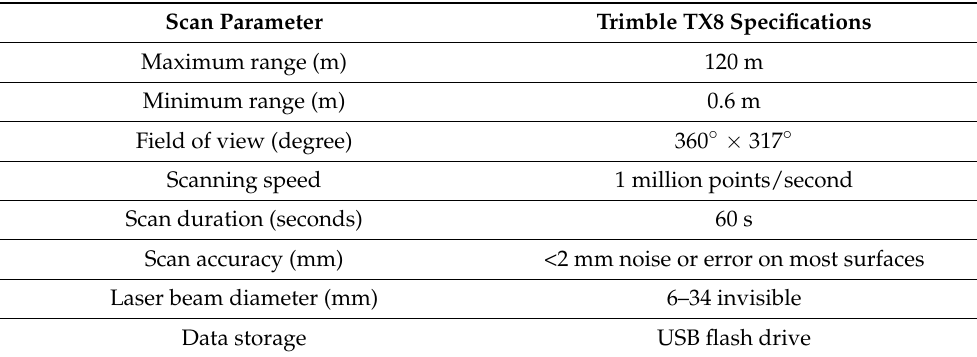
Table 3. The Technical Specifications of Trimble TX8 Laser